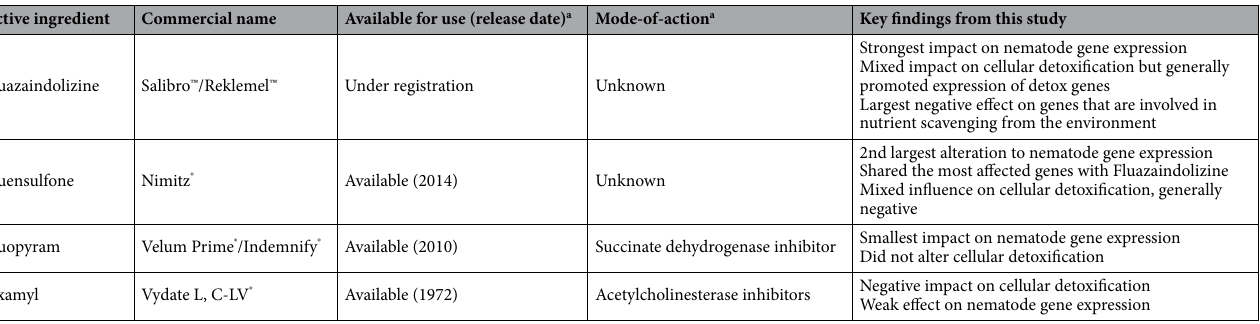
Table 1. Key findings and commercial nematicide product information. a Information obtained from Desaeger et al. 8